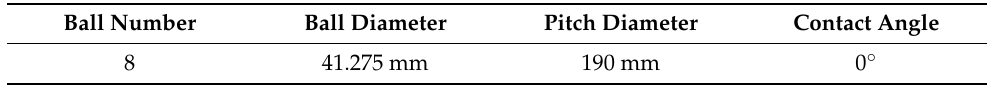
Table 3. Parameters of the SKF6324 bearing.